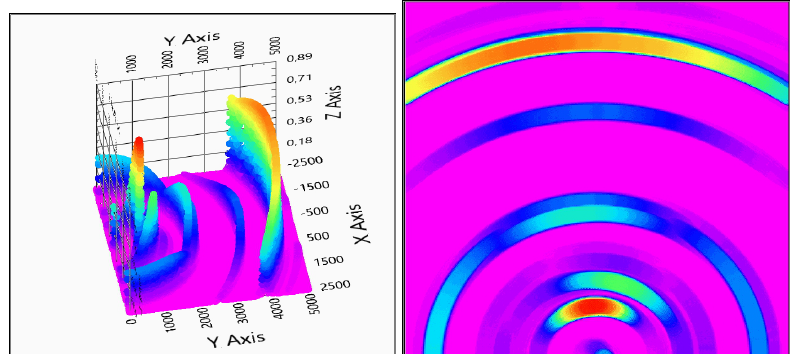
Figure 17. Evaluation of indoor test no .2 (2 receivers). In the right column, the top view is also shown ( x , y : x , y space axis, z -axis: probability of solid object in x , y defined position).